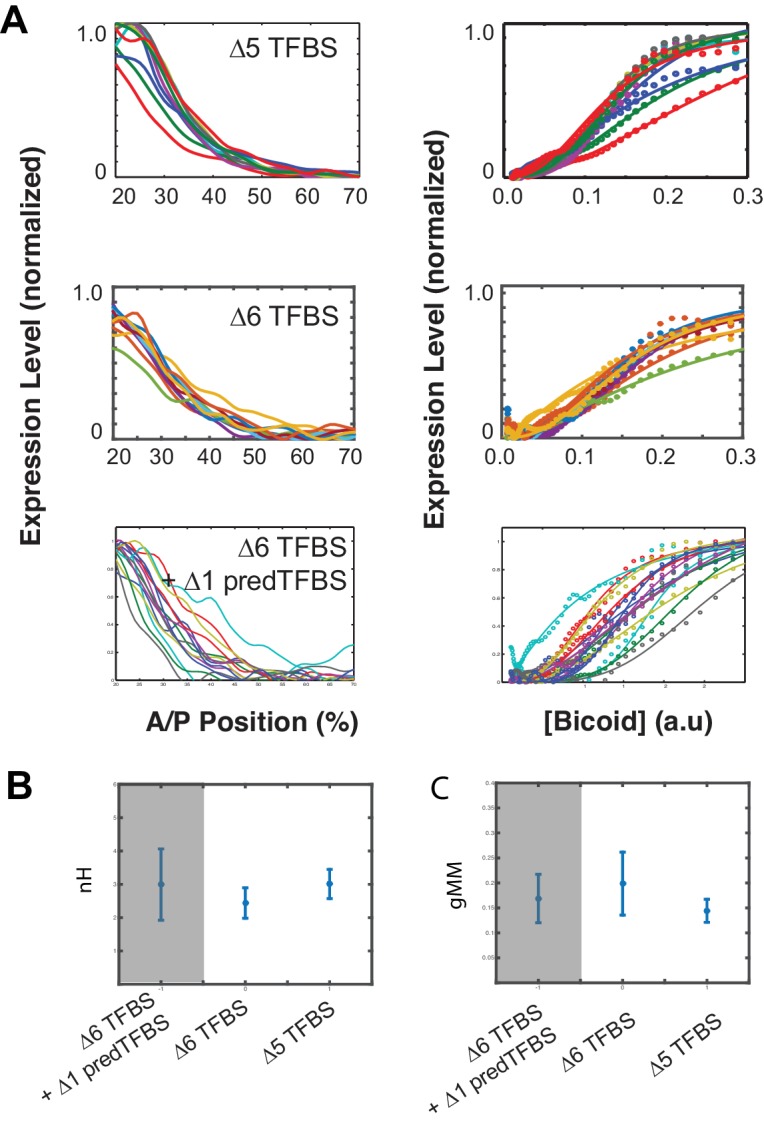
Residual expression remains even after removing all six canonical Bcd TFBS, and also two additional predicted TFBSs.The WTHbP2 sequence contains six canonical predicted Bcd binding sites and one additional predicted site that overlaps with X3. The native hb promoter also contains an additional predicted Bcd binding site. We removed both of these sites (delta6 TFBS +delta1 predTFBS) and measured expression in reporter constructs in embryos. We also show data from delta6, where all six canonical WTHbP2 Bcd binding sites have been removed, and data from delta5 for comparison (also shown in Figure 2). (A) (left) mRNA expression profile obtained from embryos that carry transgenic reporter constructs with Bcd TFBS removed. (right) Bcd/LacZ GRF for each reporter construct. Dots represent measured value and lines show a fit to Hill function. (B) Hill Coefficient (nH) obtained from each reporter construct, reflecting the shape of the GRF. (C) The generalised Michaelis-Menten constant obtained from each construct, reflecting the location of the expression boundary.